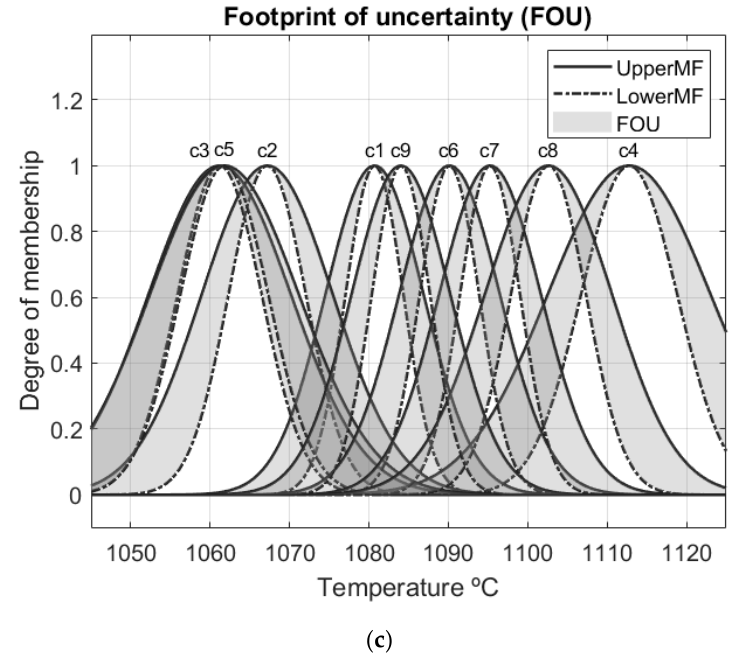
Figure 5. Fuzzy C-means (FCM) 9-rule Mamdani purely fuzzy system input and output type-2 membership functions, ( a ) x 1 , ( b ) x 2 and ( c ) y .